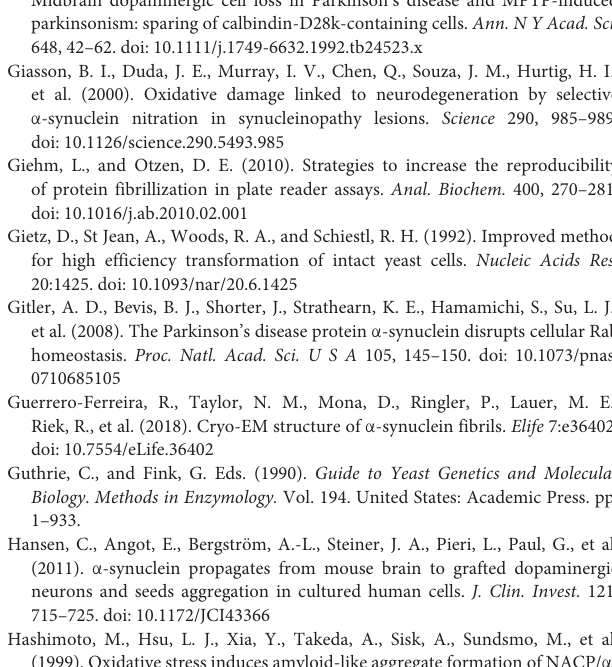
consisting only of variable region sequences without the N-terminal scaffold. The amino acid sequences are listed in Table 4 . The flanking N-terminal phenylalanine was included where it stabilized the secondary structure according to the prediction tool.